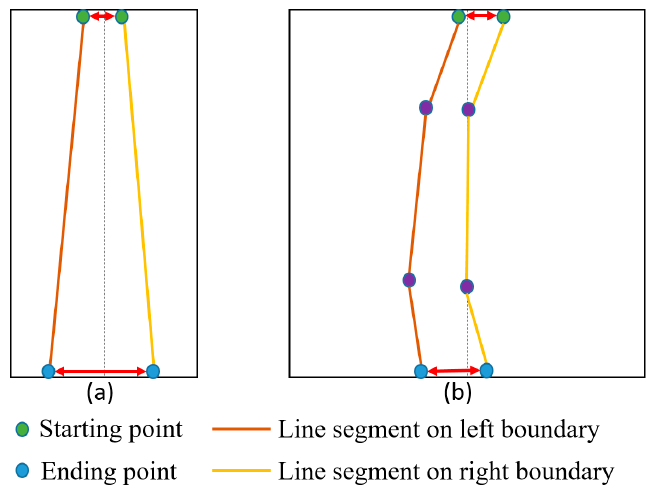
Figure 10. Distance between neighboring lines: ( a ) straight line; and ( b ) curve line.